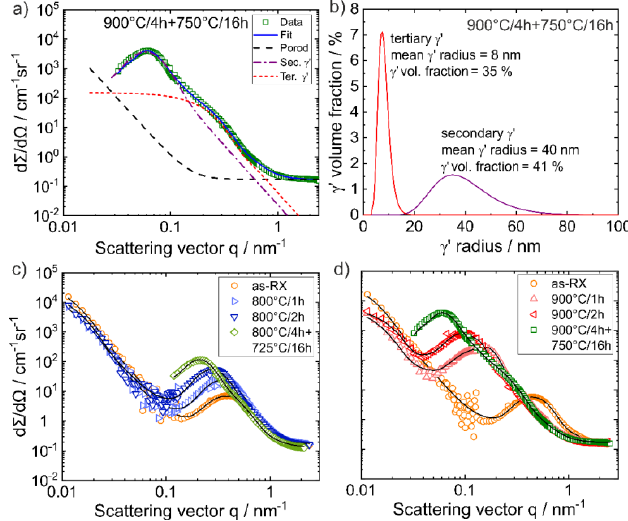
Figure 4. ( a ) Scattering curve of the condition 900 °C/4 h + 750 °C/16 h consisting of three different contributions: Log-normal size distributed secondary and tertiary γ (cid:48) precipitates and a Porod signal; ( b ) the applied log-normal size distributions. Scattering curves of the different conditions: ( c ) as-RX, 800 °C/1 h, 800 °C/2 h and 800 °C/4 h + 725 °C/16 h and ( d ) as-RX, 900 °C/1 h, 900 °C/2 h and 900 °C/4 h + 750 °C/16 h.